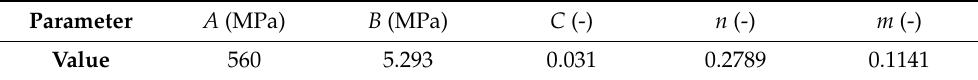
Table 5. The Johnson–Cook flow stress model parameters of AISI H13 determined by tensile tests. Parameter